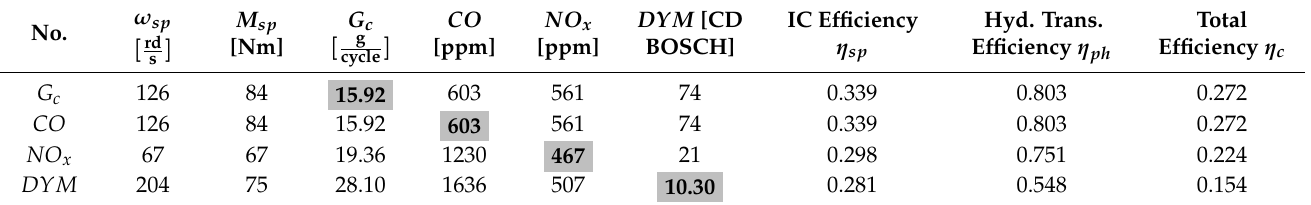
Table 10. Optimal combustion engine duty points for load I and accumulator capacity V a = 0.04 [m 3 ].